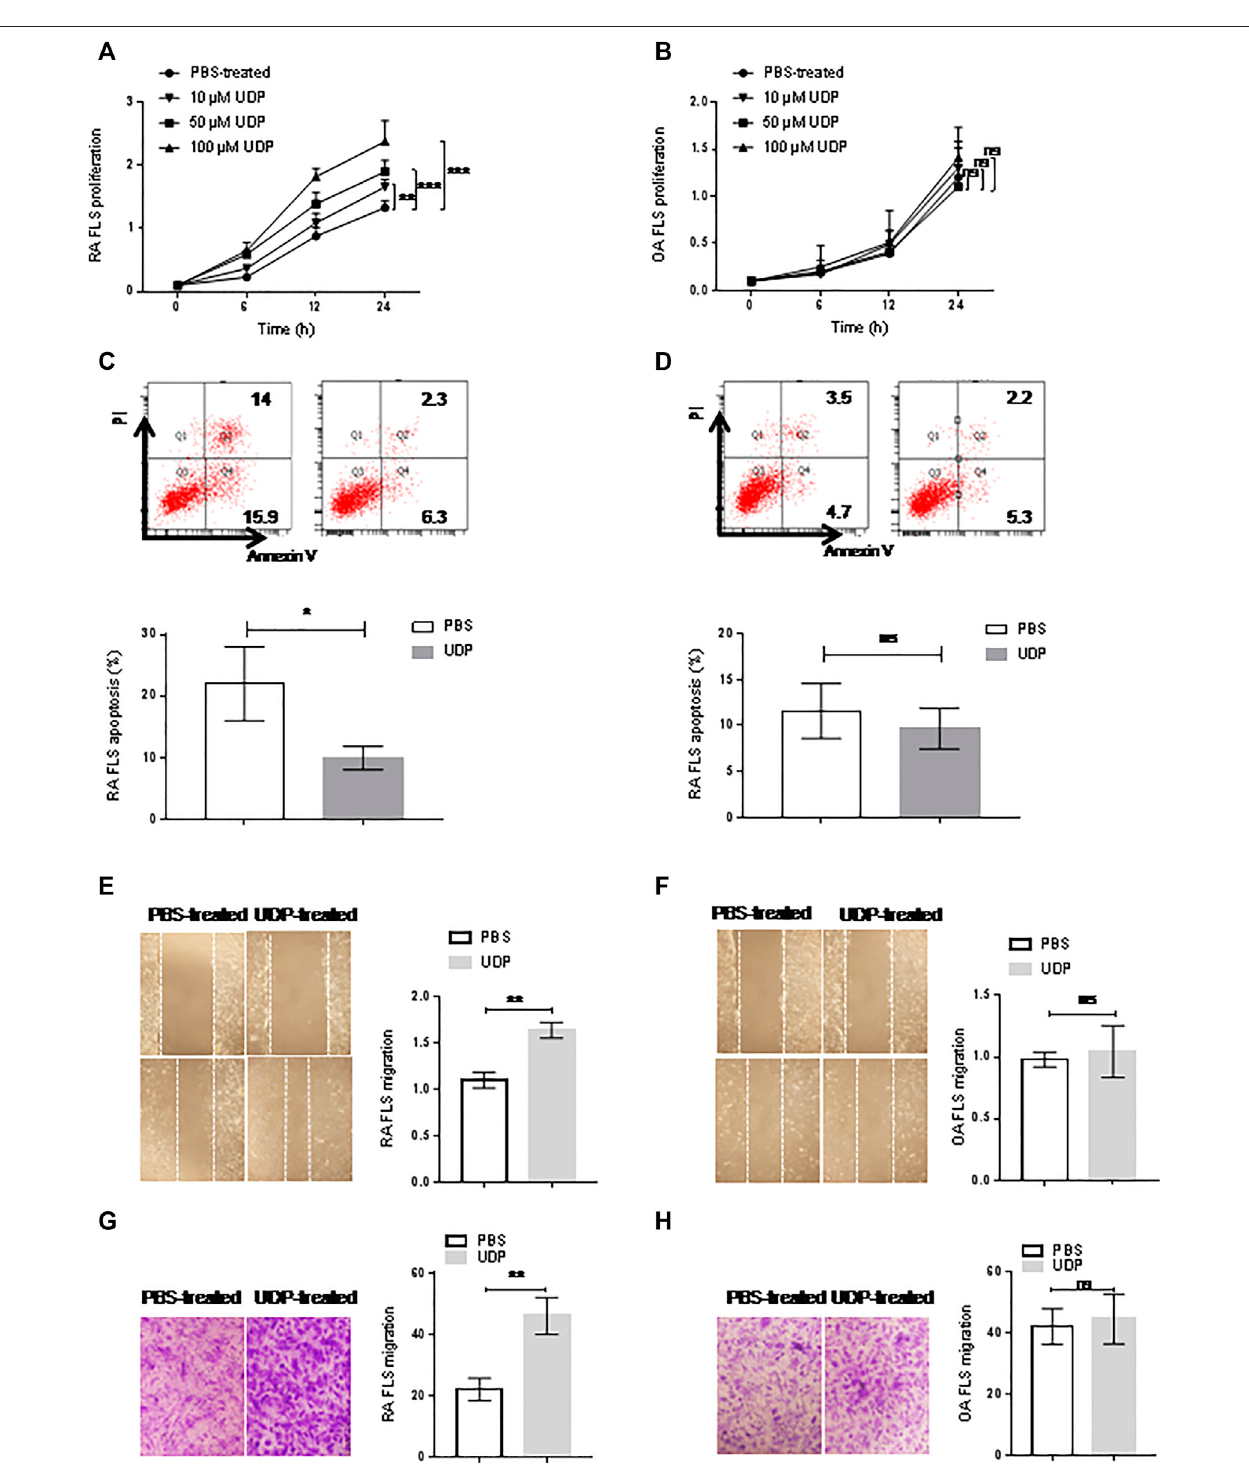
FIGURE3| TheeffectofUDPonsynovial fi broblastcells.CellproliferationofRA (A) orOA (B) synovial fi broblastcells( n (cid:1) 5foreachdisease)wasassessedusinga CCK-8assay.ApoptosisofRA (C) orOA (D) synovial fi broblastcells( n (cid:1) 5foreach disease)wasassessed using fl owcytometryandstatisticalanalysis.Cellmigrationof RA (E) or OA (F) synovial fi broblast cells ( n (cid:1) 5 for each disease) was assessed using a wound healing assay and statistical analysis. (G) Cell migration of RA or OA (H) synovial fi broblast cells ( n (cid:1) 5 for each disease) was assessed using a Transwell assay and statistical analysis. These experiments were repeated three times. FLS: synovial fi broblast cells. * p < 0.05, ** p < 0.01 and *** p < 0.001.